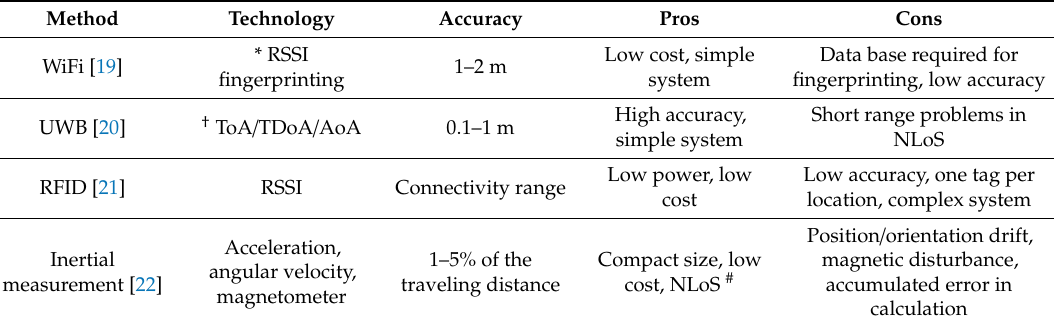
Table 1. The commonly used indoor localization